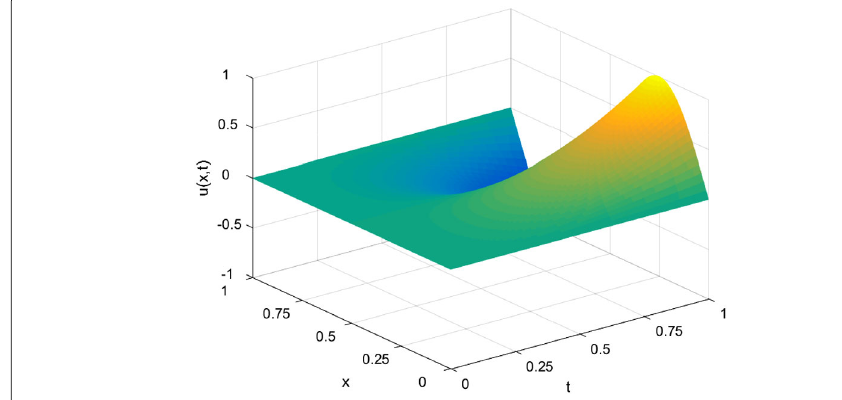
Figure 3 Surface of the implicit scheme solution ( α =